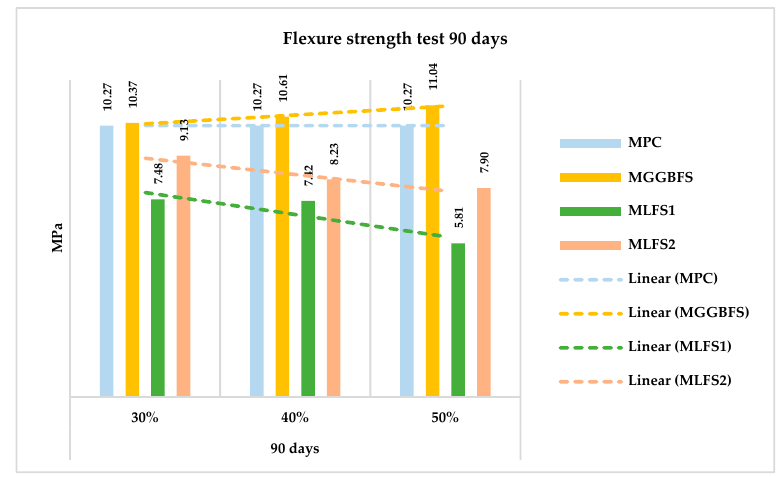
Figure 11. Flexure strength test at 90 days.